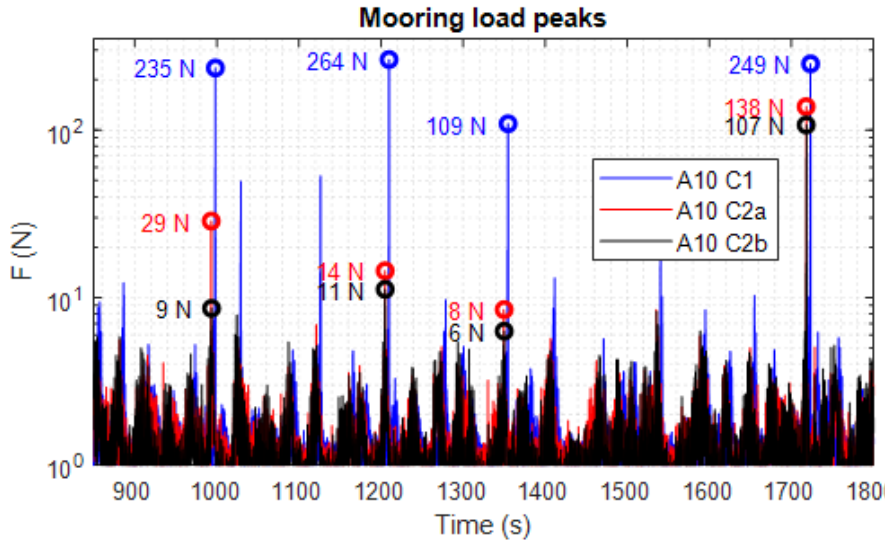
Figure 26. Mooring load time traces sample: 10-year wave, C1, C2a, and C2b